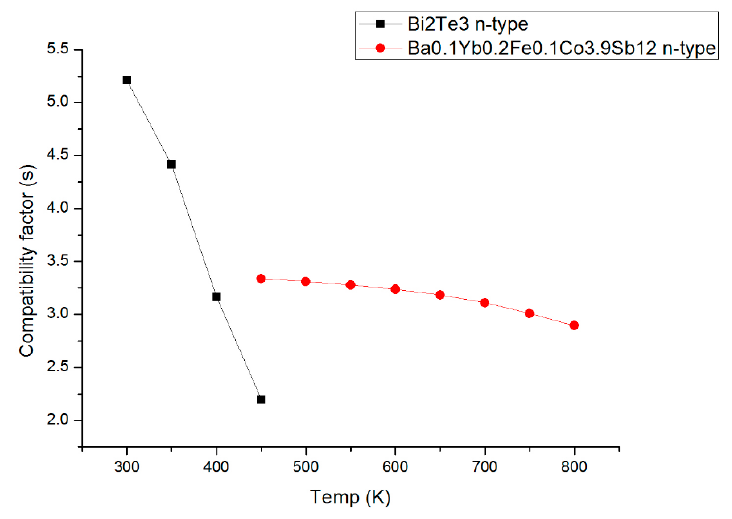
Figure 4. N-type compatibility factor of the materials.